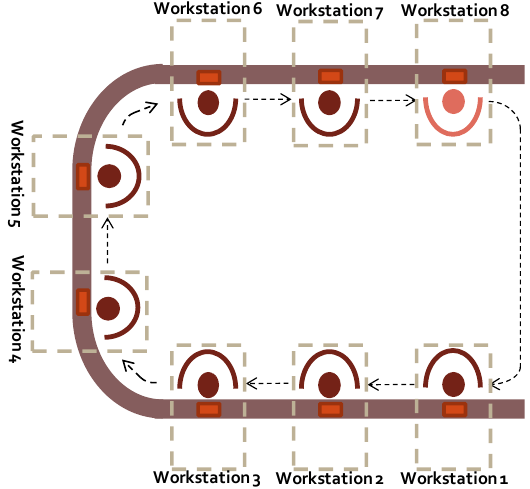
Figure 2. Assembly cell